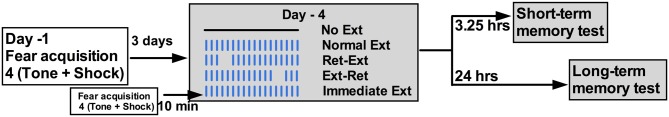
Schema of Experiment 2. Tone; 77dB; 30 s each, Shock = 0.8 mA; 2 s each, Inter trial interval (ITI) = 2 min during fear conditioning in context A. Fear conditioning was done one Day-1 and extinction was done on Day-4. Short-term test was done 3.25 h after extinction procedures on Day-4. Long-term test was done 24 h after extinction procedures on Day-5. On extinction day in context B, Ret—Ext and Ext—Ret groups received a retrieval session consisted of 3 massed tones, 5 s ITI and extinction session consisted of 50 massed tones, 5 s ITI. Retrieval and extinction sessions were 10 min apart.